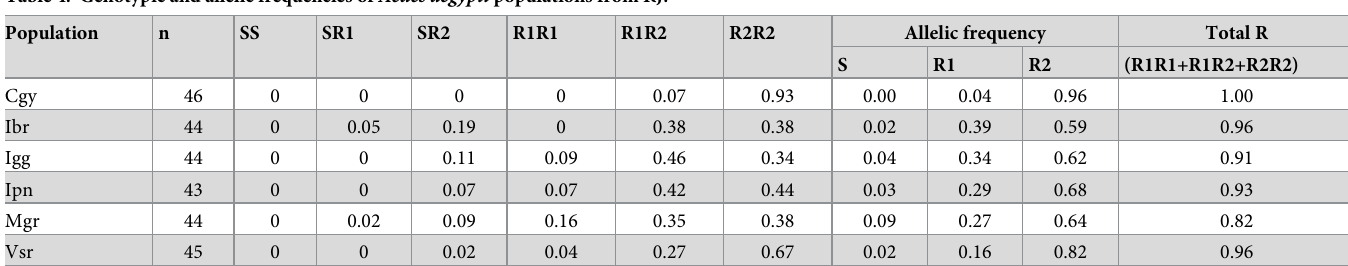
Table 4. Genotypic and allelic frequencies of Aedes aegypti populations from RJ.